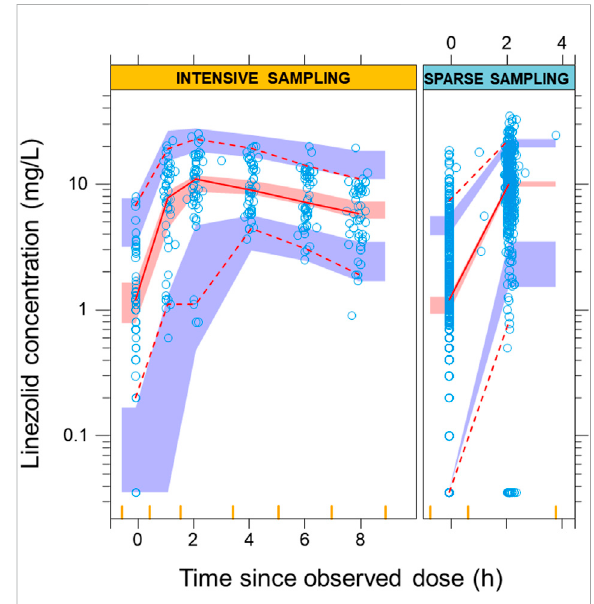
FIGURE 2 Visual predictive check from the fi nal model. The solid and dashed lines correspond to the fi fth, 50th, and 95th percentiles from the original observations (blue circles), while the shaded areas represent the 95% con fi dence intervals for the same percentiles of the model predictions. The left panel shows the intensive data with sampling points from pre-dose up to 8 h post- dose. The right panel shows the predictions for the sparse observations at pre-dose and 2 h post-dose The bins for sampling points are showed as vertical yellow lines on the x